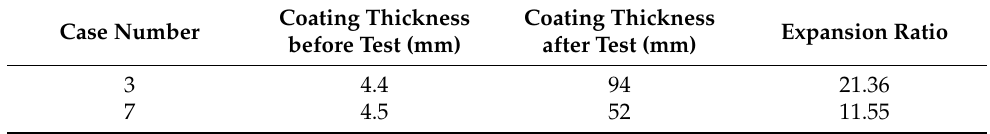
Table 6. Thickness statistics of IFC before and after the test.